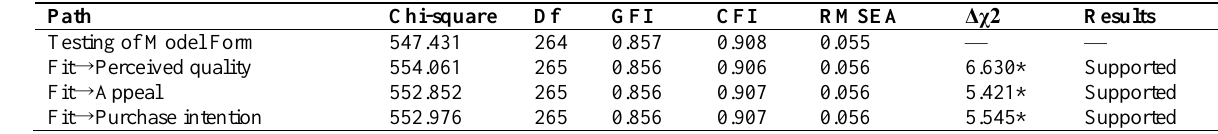
Table 13: The results of hypothesis testing for moderating